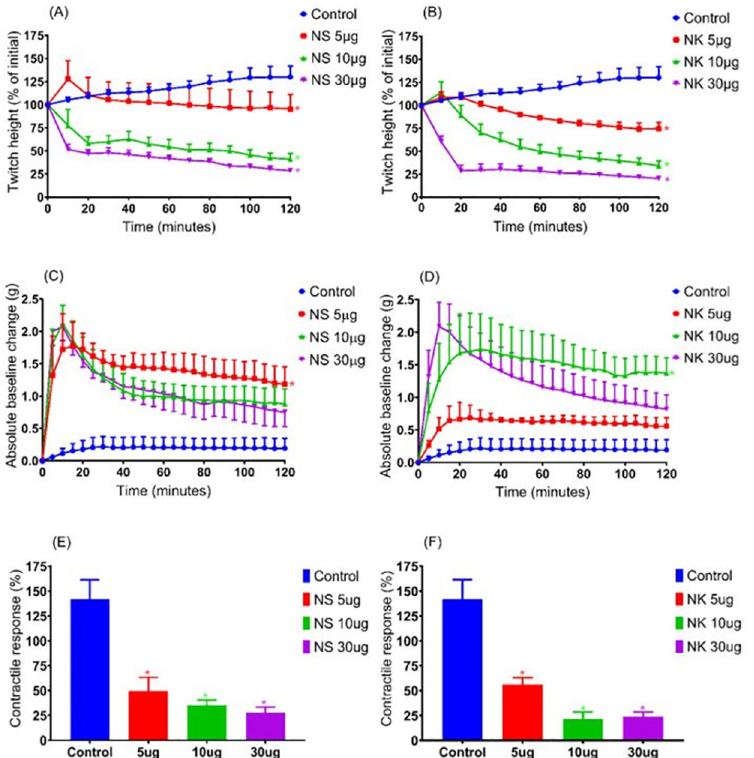
Fig 7. Myotoxic effects of Malaysian N . sumatrana venom and N . kaouthia venom in directly stimulated twitches of the chick biventer cervicis nerve-muscle preparation. Panel (A) N . sumatrana venom and (B) N . kaouthia venom indicate change in the direct twitch height in tissue added with different concentration (5–30 μ g/ml) venom. Panel (C) N . sumatrana venom and (D) Absolute baseline change of tissues after addition of (C) N . sumatrana venom and (D) N . kaouthia venom while on direct twitches. Panel (E) N . sumatrana venom and (F) N . kaouthia venom indicate contractile response change to exogenous KCl in tissues exposed to on contractile responses to exogenous KCl. NS indicates N . sumatrana venom and NK indicates N . kaouthia venom. � p < 0.05, significantly different from control (distilled water) (n = 4, one-way